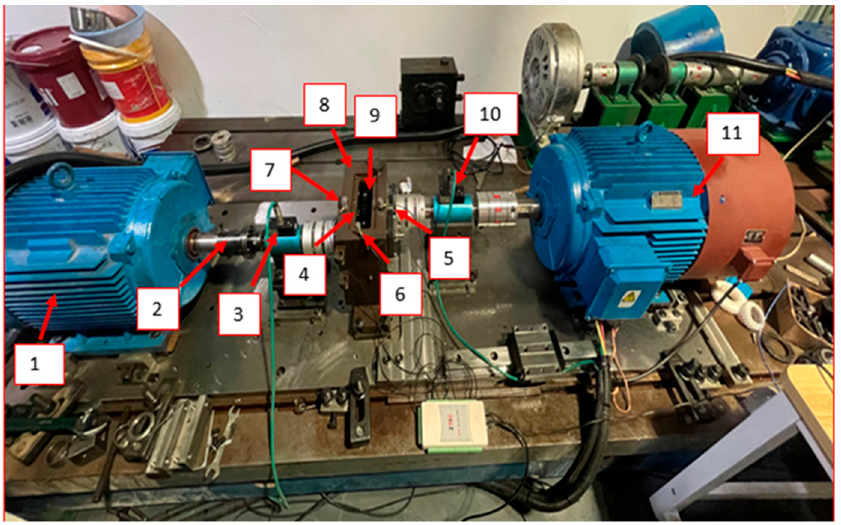
Figure 11. Gear test bench set up. 1,11-Active motor, 2-Coupling, 3,10-Torque speed sensor, 4-drive gear, 5,6,7-Linear acceleration sensor, 8-Gearbox, 9-driven gear.